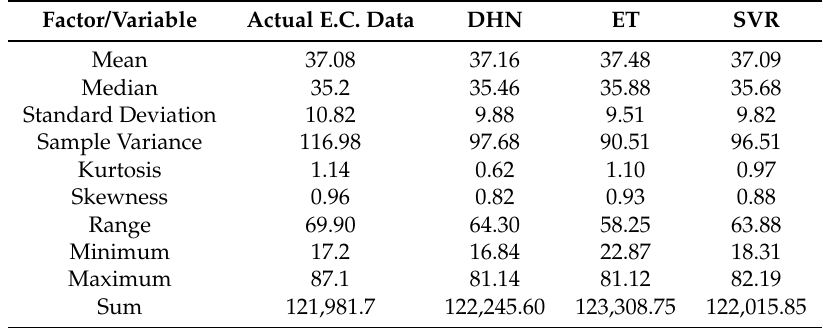
Table 11. Statistical measures on testing dataset for DHN, ET and SVR.